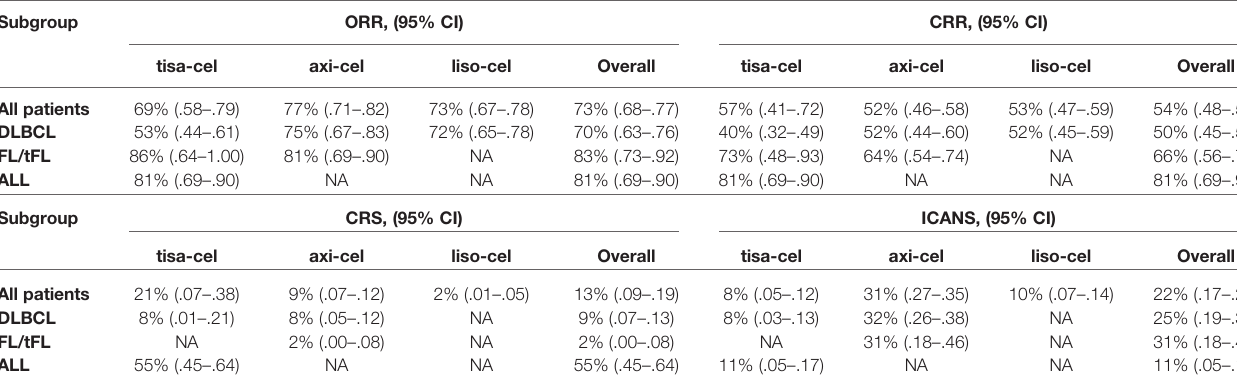
TABLE 3 | The results of performed meta-analysis in subgroups of product and